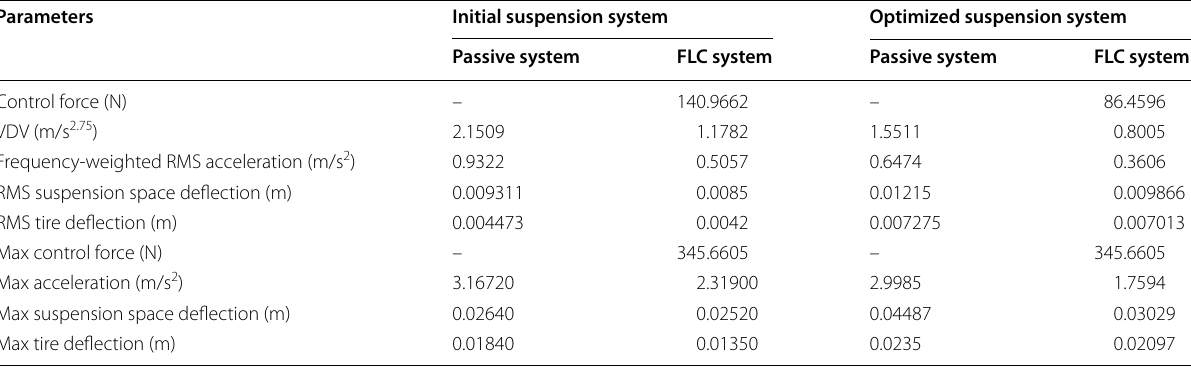
Table 2 FLC and passive suspension system